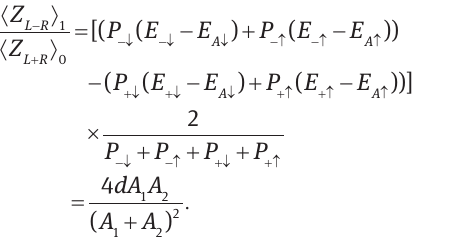
of which there are three published values (0.10(1) [17], 0.22 [18], and 0.164(6) [19]). There is only one pub- 0.017(2) [19]. This is in reasonable agreement with our